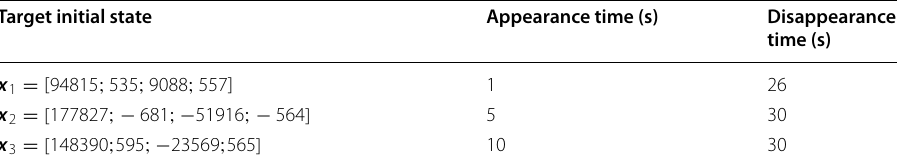
Table 1 The initial position of the targets Target initial